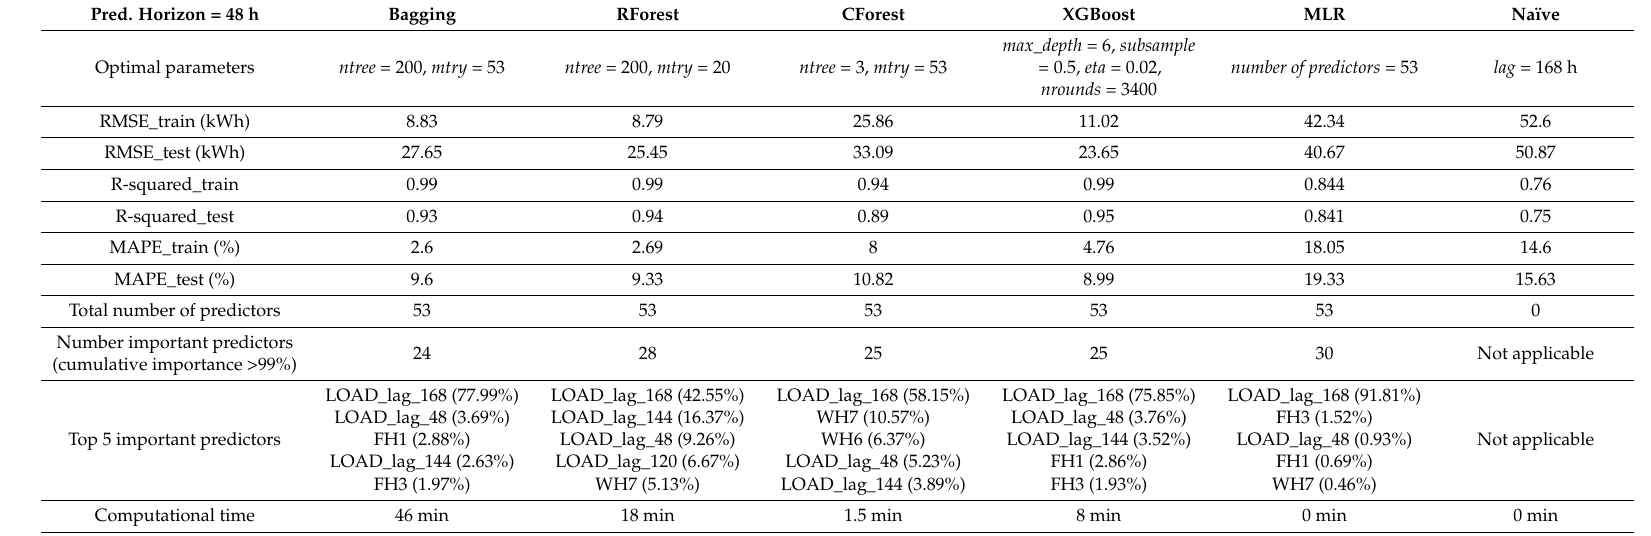
Table 6. Accuracy results for the ensemble